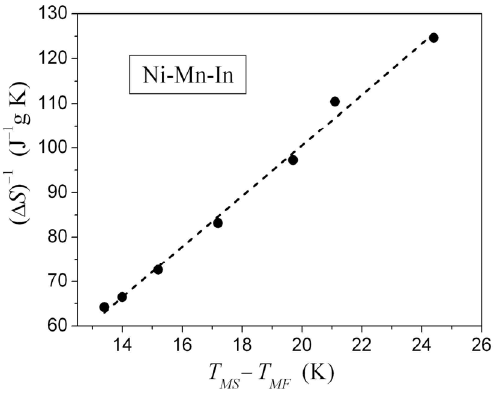
Figure 15. The experimental verification of the inverse proportionality of two-phase temperature interval to entropy change [96]. The dashed line presents a linear fit to the experimental